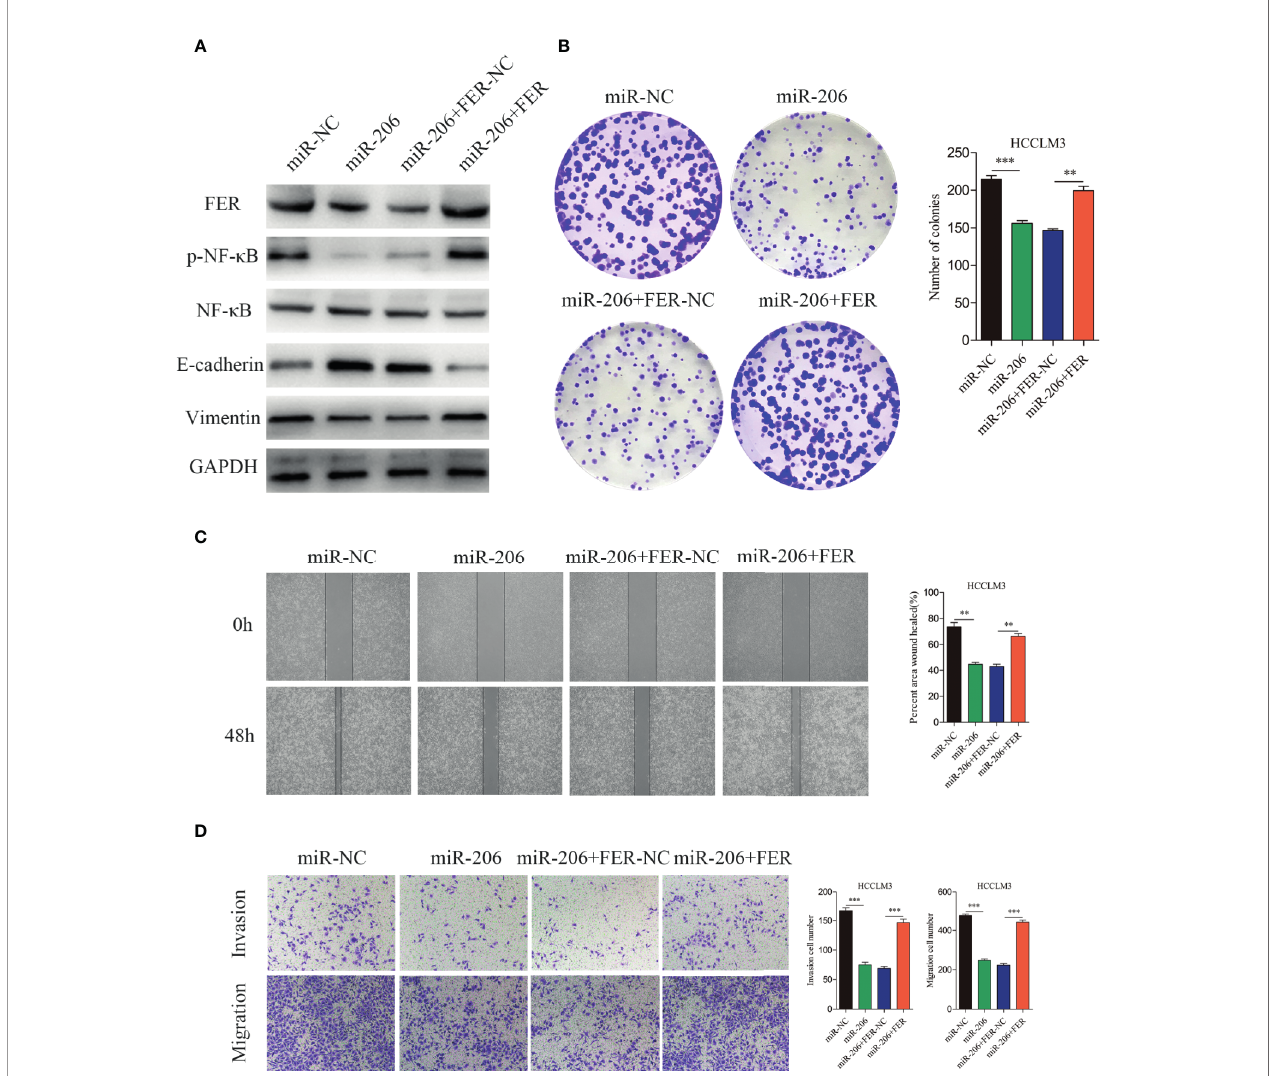
FIGURE 7 | Rescue experiments were used to con fi rm that miR-206 is an upstream regulator of FER. (A) Western blotting analyses were used to analyze the FER overexpression-induced changes in the p-NF- k B, NF- k B, E-cadherin and vimentin expression levels in HCCLM3 cells treated with miR-206 mimic. (B) The colony formation assay was performed to determine the colony forming ability of the indicated groups. (C) Wound healing assays showed that FER overexpression restored the attenuated cell migration in HCCLM3 cells overexpressing miR-206. (D) The cell invasion and migration abilities of HCCLM3 cells treated with different lentiviruses were evaluated by transwell assays. (**P < 0.01, ***P <